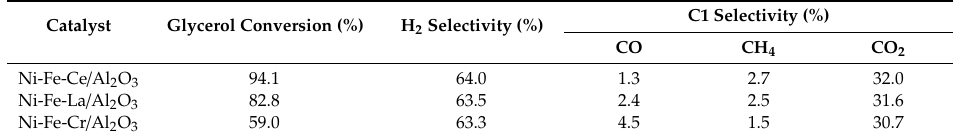
Table 7. The catalytic performance in the SR of glycerol over Ni-based Fe modified catalysts [85] (used with copyright permission).